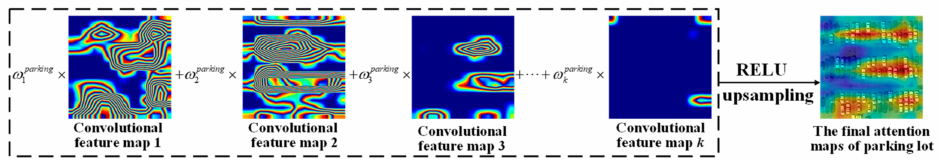
Figure 5. The convolutional feature maps and lass-discriminative attention map in the Grad-CAM method.